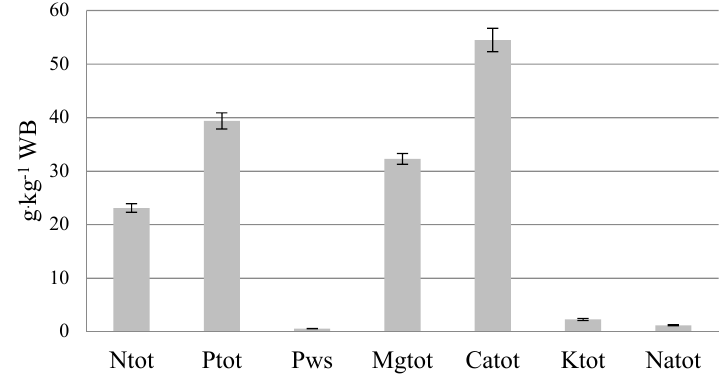
Figure 4. Macronutrients content in STR from the farm scale bio-refinery plant.